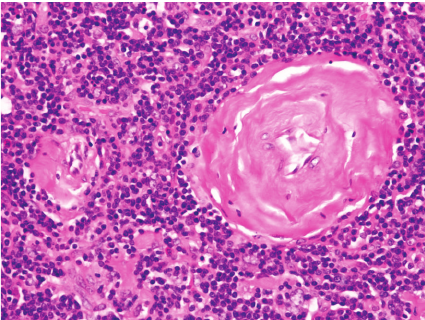
Figure 5: Higher magnification photomicrograph showing the prominent hyalinization around the vessels (20x; H&E).